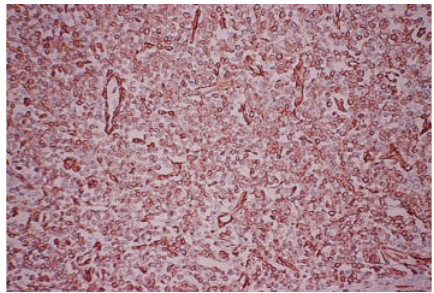
Figure 3: PNET arising in the liver: positive immunoexpression for vimentin, streptavidin-biotin, 200x.